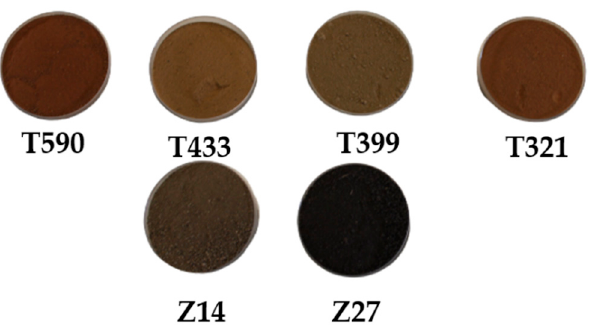
Figure 2. Subset of soil samples. Prefix Z denotes samples from Zazari region, while the T denotes samples from the region of the Republic of North Macedonia.